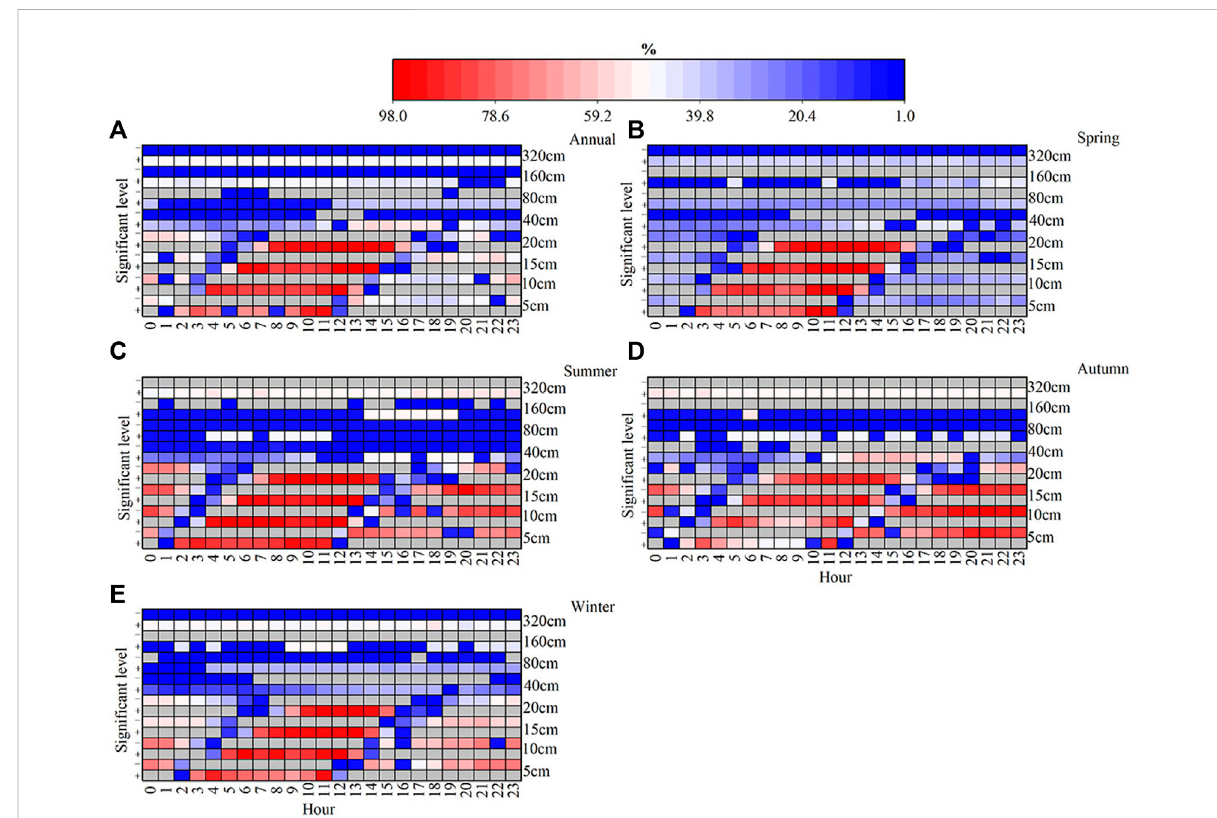
FIGURE 4 Station percentages of annual (A) , Spring (B) , Summer (C) , Autumn (D) and Winter (E) soil temperature change trend at depths of 5 – 320 cm during 2004 – 2020 in Yunnan (plus sign indicates signi fi cant percentage increase, minus sign indicates signi fi cant percentage decrease, and gray shading indicates percentage without signi fi cant increase or